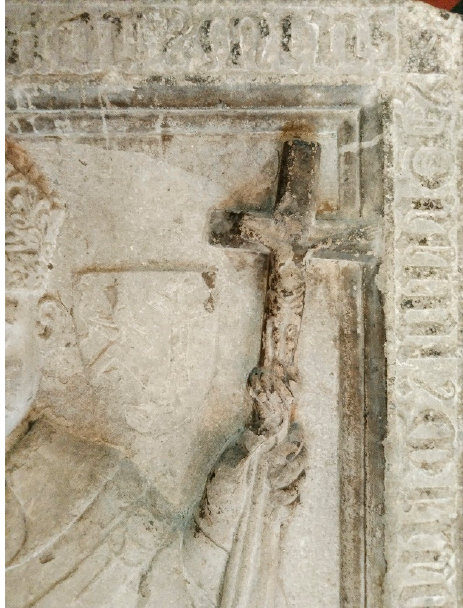
Figure 20. Tomb of Archbishop Tregury, St Patrick’s Cathedral, Dublin, c.1471. Photograph by the